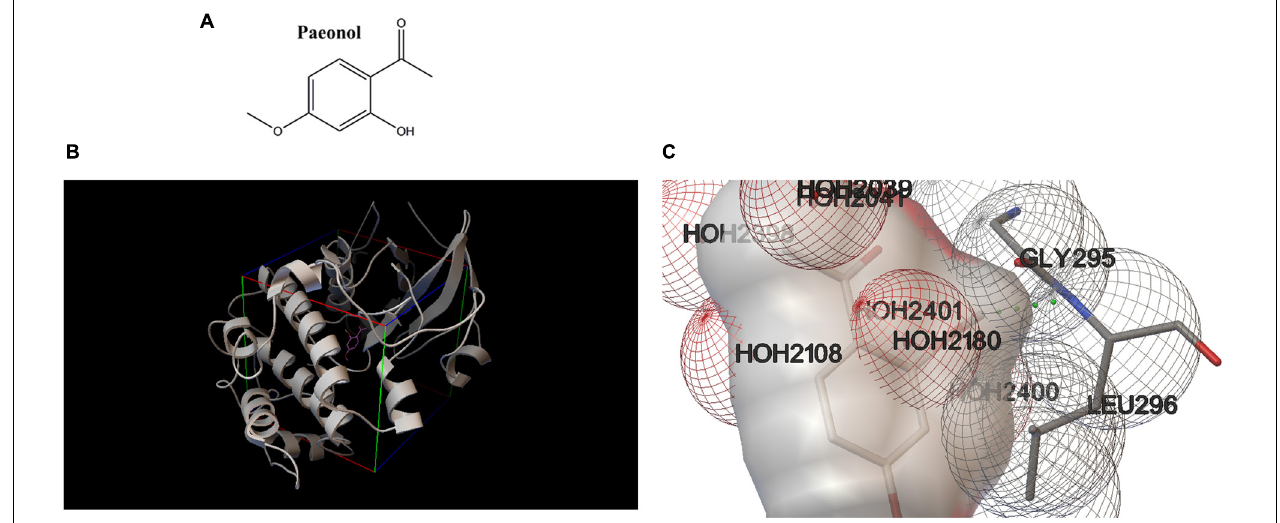
FIGURE 7 | Molecular docking revealed a direct combination between paeonol and Akt2 crystal structure (PDB code: 1O6L). (A) Chemical structure of paeonol. (B) Docking pose of paeonol in the active pocket of the Akt2 crystal structure. (C) Paeonol formed one steady hydrogen bond with